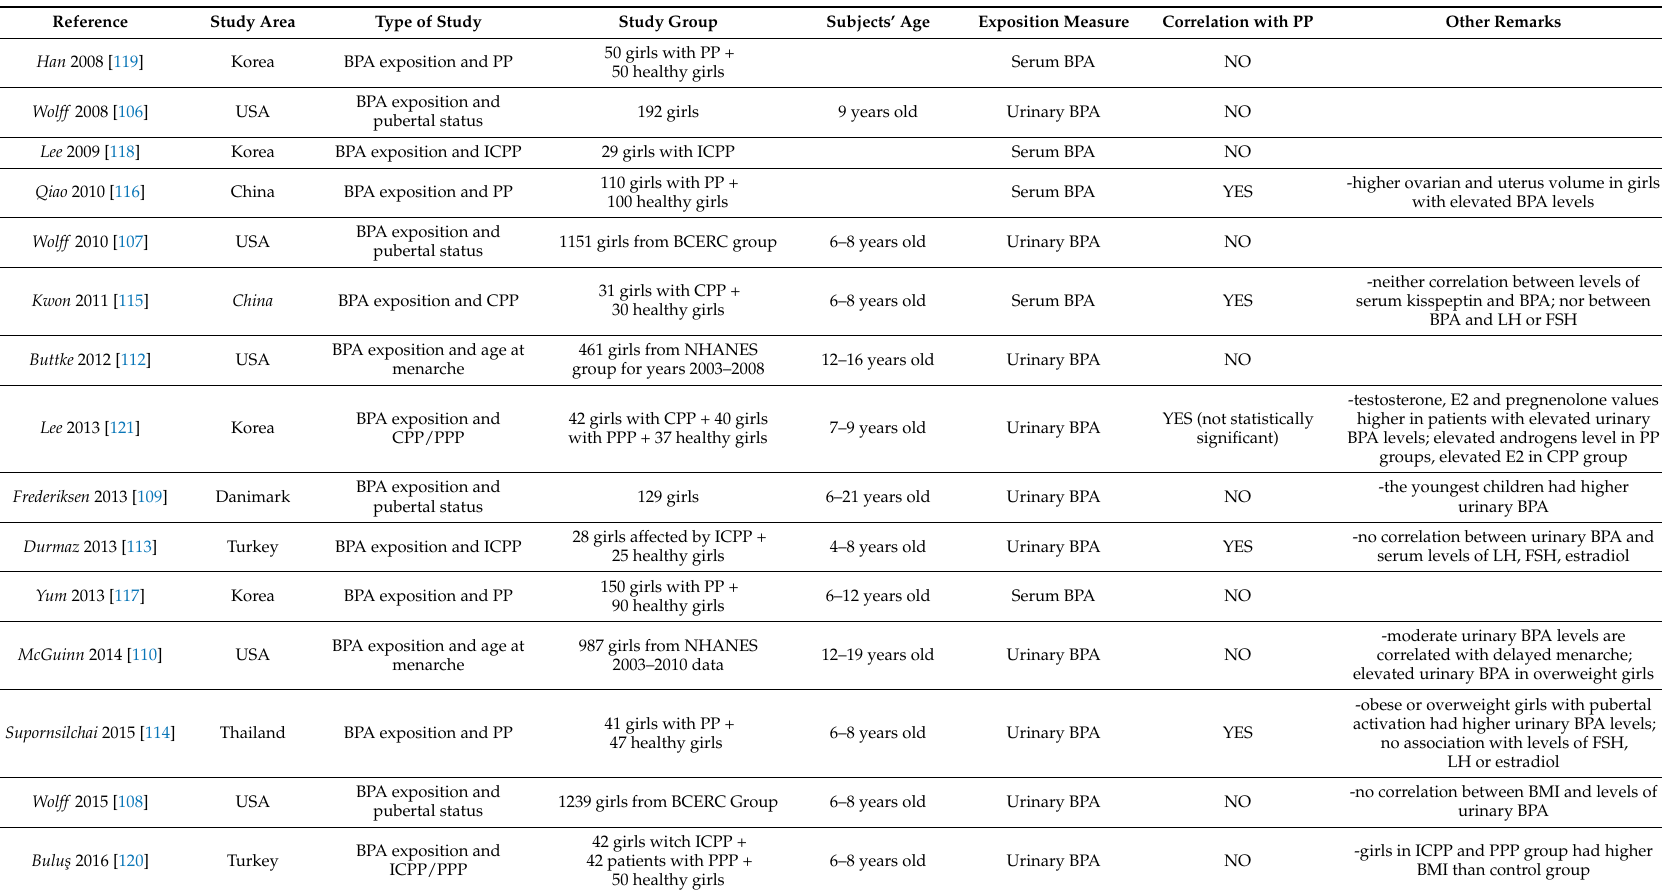
Table 1. Overview of epidemiological studies investigating the relationship between bisphenol A (BPA) and precocious puberty in